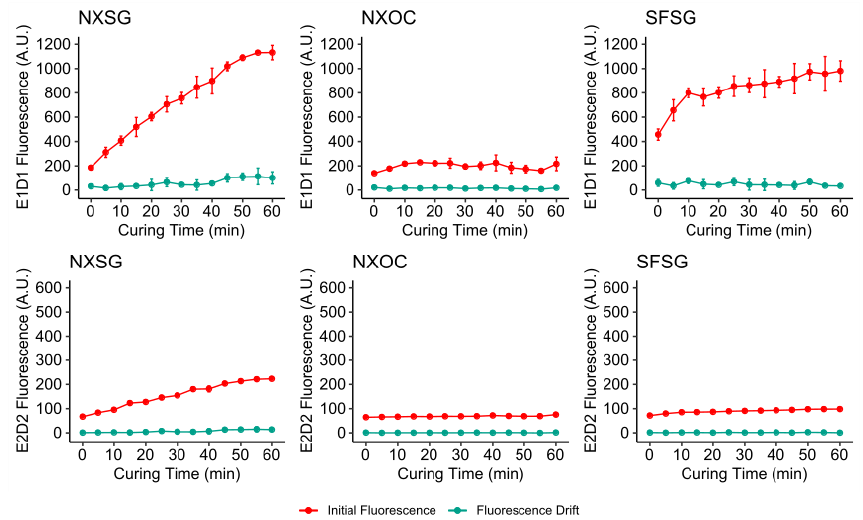
Figure 6. Results of background fluorescence and drift measurements for microreactors post cured at 60 °C. All measurements were performed on three microreactors for each material.